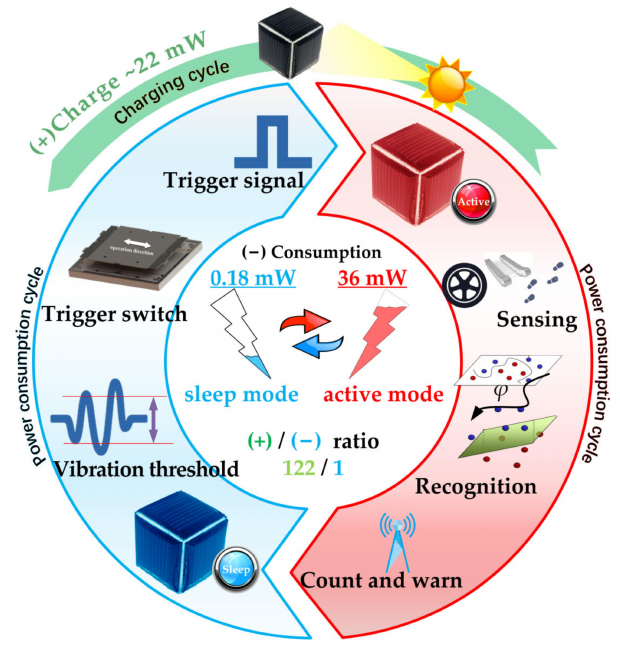
Figure 1. Overall working principle of microsystem.